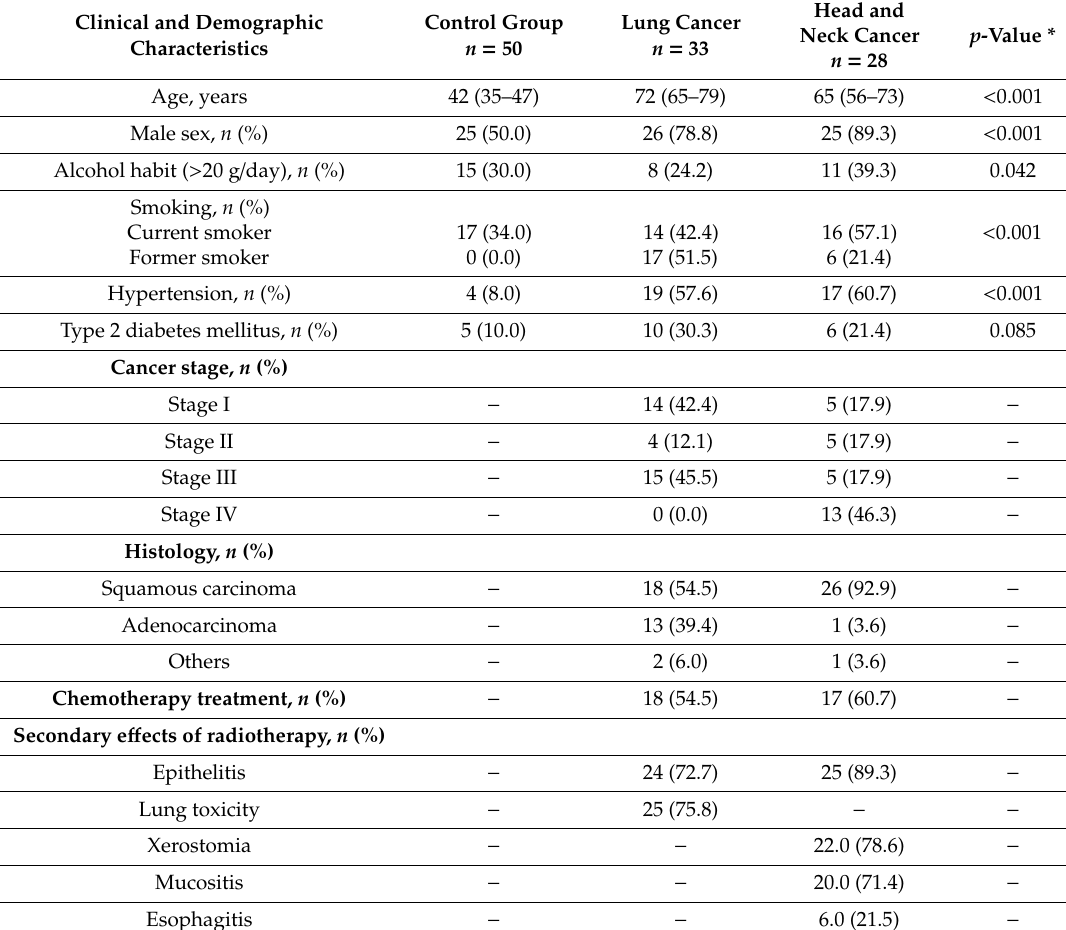
Table 1. Clinical and demographic characteristics of the lung cancer and the head and neck cancer patients and the control